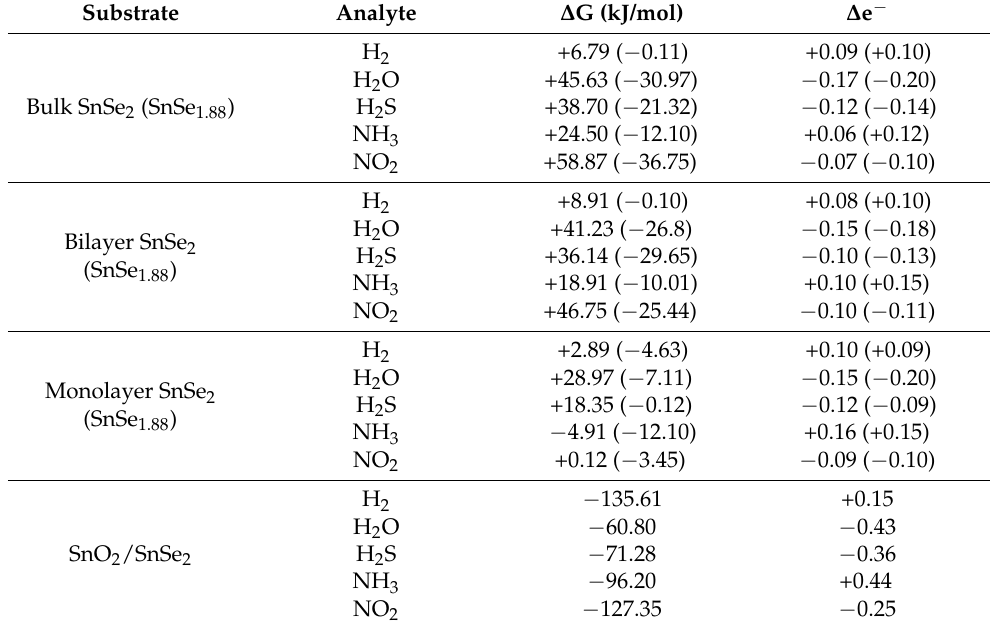
Figure 9. Change of charge densities after adsorption of ( a , c , e ) NH 3 and ( b , d , f ) H 2 S on ( a , b ) bulk and ( c , d ) monolayer of SnSe 2 and, moreover, ( e , f ) the SnO 2 skin on an underlying SnSe 2 substrate. Table 3. Differential Gibbs free energies ∆ G of physisorption at 200 ◦ C and corresponding values of transferred charge for various combination of considered substrates and analytes Substrate